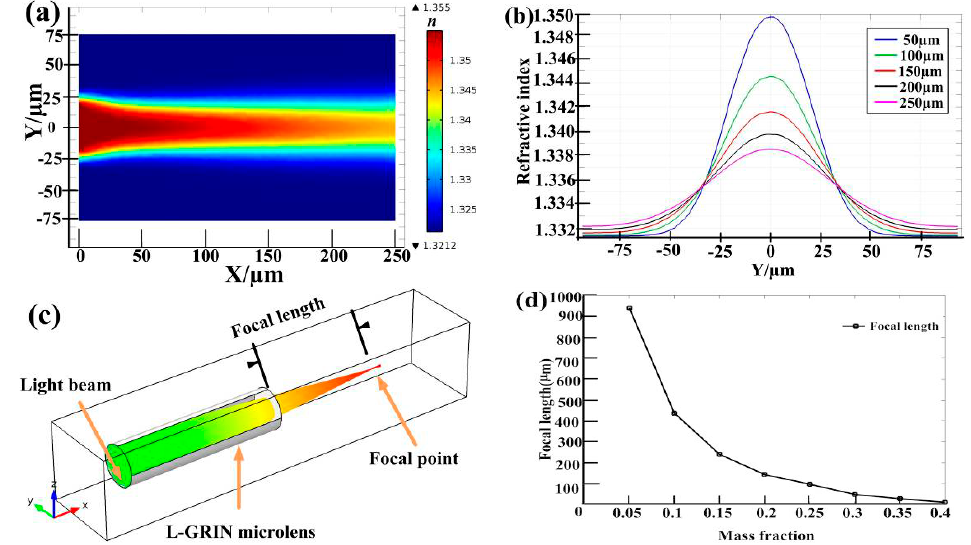
Figure 4. ( a ) The refractive index profile in the xoy plane with the mass fraction of 0.2; ( b ) The cross-sectional refractive index profiles at five different locations ( x = 50, 100, 150, 200 and 250 μm) with Q core = 1 × 10 3 pL/s, Q clad =8 × 10 3 pL/s; ( c ) Beam transmission and focusing process; ( d ) The focal length of the L-GRIN microlens with different mass fractions of the ethylene glycol solution.